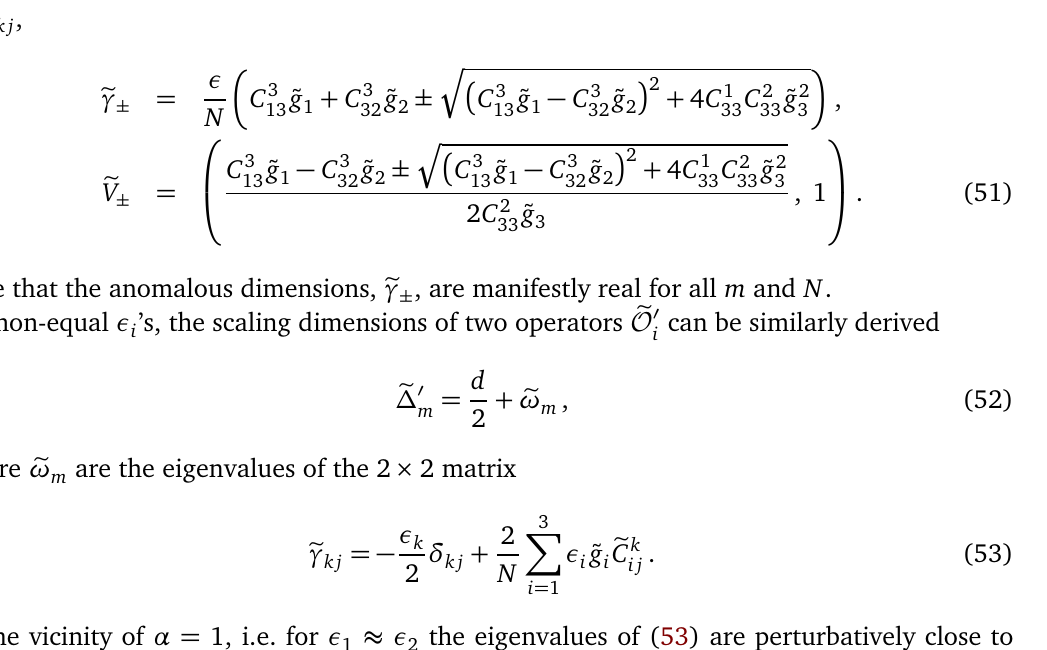
Figure 2: Linear order contribution to the correlator 〈 (cid:102) O (cid:48) represent propagators of the scalar fields. Integration is done over the insertion point x